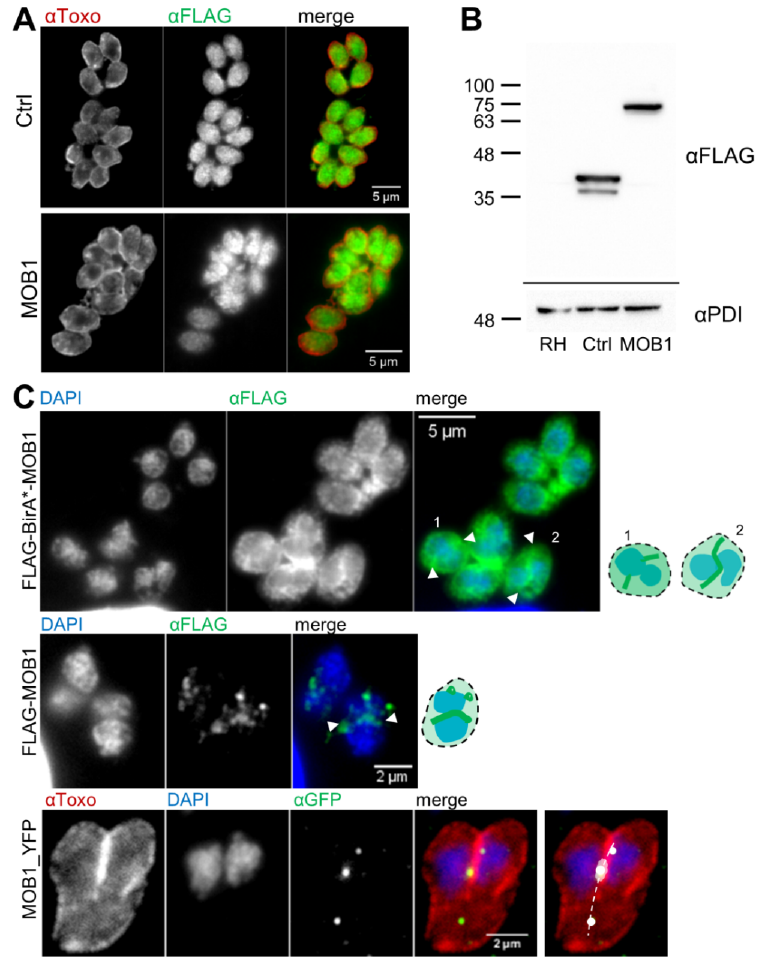
Figure 5. MOB1 accumulates between the two newly formed nuclei during endodyogeny. ( A ) The localizations of the predicted recombinant proteins of the control (Ctrl) and MOB1 clonal lines were detected through immunofluorescence, showing a similar distribution within the cell. T. gondii surface proteins were identified with polyclonal sera ( α Toxo) while the FLAG-tagged recombinant proteins were identified using anti-FLAG ( α FLAG). ( B ) The expressions of the recombinant proteins by the Ctrl and MOB1 clonal lines were confirmed by Western blot analysis, presenting molecular masses compatible with the predicted 41 kDa for FLAG-BirA* and 76 kDa for FLAG-BirA*-MOB1, respectively. The protein disulfide isomerase (PDI) was used as a loading control. Numbers on the left represent molecular mass in kDa. ( C ) Subcellular localization of recombinant and endogenous MOB1 proteins at the end of mitosis. FLAG-BirA*-MOB1 accumulates between the two newly divided nuclei at the end of mitosis when the new nuclei finish segregation but are still very close, forming a distinct linear pattern (arrowheads). During the rest of the cell cycle, FLAG-BirA*-MOB1 was observed in the cytoplasm excluded from the nucleus. The recombinant protein FLAG-MOB1 showed a pattern similar to that observed for FLAG-BirA*-MOB1, accumulating between the two daughter nuclei (arrowheads). During the rest of the cell cycle, FLAG-MOB1 was also observed in the cytoplasm. Endogenous MOB1 was detected in a punctate linear pattern between the two daughters, in a pattern similar to that observed with the recombinant MOB1 proteins. A graphical representation of the observed MOB1 accumulation is represented in the detail on the right for each panel. The recombinant proteins FLAG-BirA*-MOB1 (driven by a strong promoter) and FLAG-MOB1 (driven by a moderate promoter) were analyzed using anti-FLAG ( α FLAG). The subcellular localization of endogenous MOB1 was observed using the MOB1_YFP strain and staining with anti-GFP ( α GFP) and polyclonal anti- T. gondii surface proteins ( α Toxo). DNA is stained with DAPI. Ctrl, FLAG-BirA*; MOB1, FLAG-BirA*-MOB1.